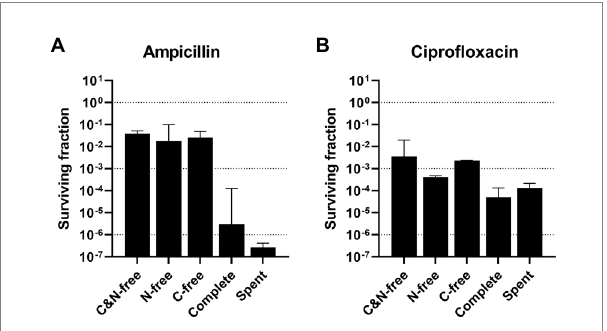
FIGURE 1 Surviving fractions after high-antibiotic stress (HAS) in different media. Aliquots of mid-exponential phase Escherichia coli WT at OD600 = 0.5 in shake flasks were centrifuged and resuspended in different stress media (without either carbon or nitrogen source or both, complete, or spent) and treated with (A) 100 μ g/ml ampicillin or (B) 5 μ g/ml ciprofloxacin for 5 h. Viable cell counts were assayed at 0 and 5 h after treatment, and the surviving fractions at 5 h were calculated. Geometric mean and geometric standard deviation from 2–4 experiments are plotted, with a dotted line at 10 0 , 10 − 3 , and 10 − 6 to aid interpretation. HAS, high-antibiotic stress; C&N-free, lacking both carbon and nitrogen; N-free, lacking nitrogen; C-free, lacking carbon; spent, supernatant from mid-exponential phase